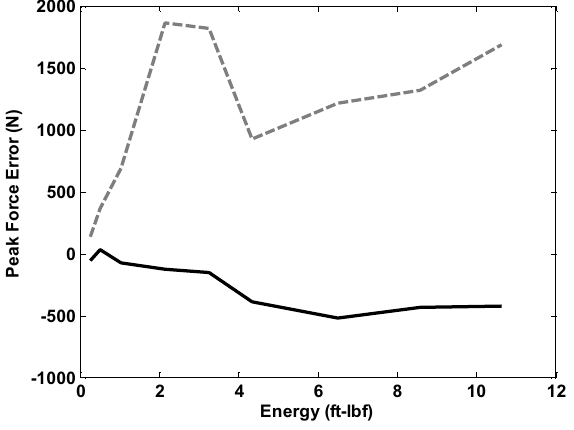
Fig. 26. Comparison of the difference between the actual peak force and the peak force of the originally estimated (——) and adjusted curve-fit (– – –) forces. The magnitude of the drop-tower force at low frequencies is adjusted to follow a quadratic, curve-fit line